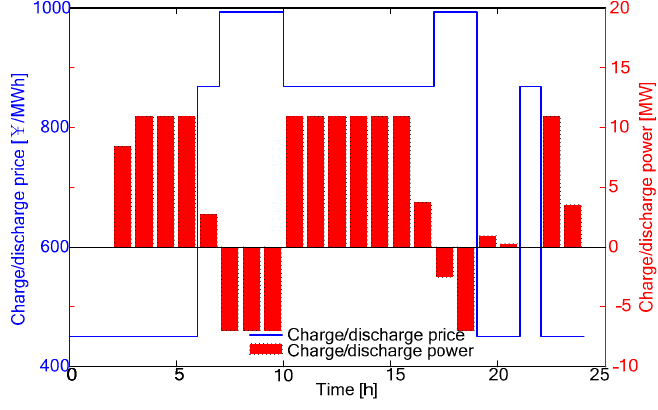
Figure 5. The weak Stackelberg equilibrium.